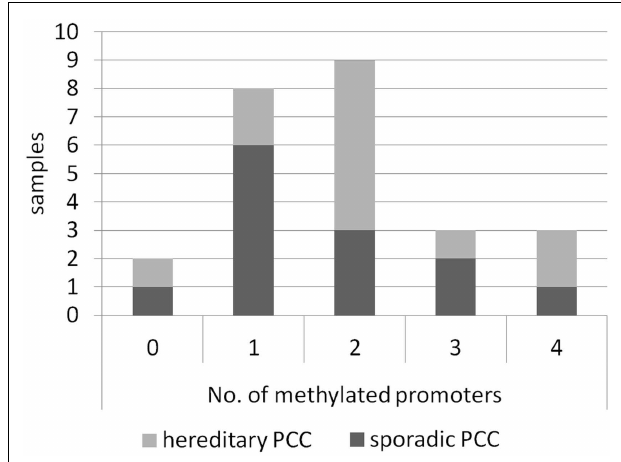
FIGURE 3 | Occurrence of co-methylated RASSF promoters in PCCs . Samples of sporadic ( n = 13) and hereditary ( n = 12) PCCs are shown regarding their number of methylated RASSF promoters for all RASSFs. For details, see Table 1 .